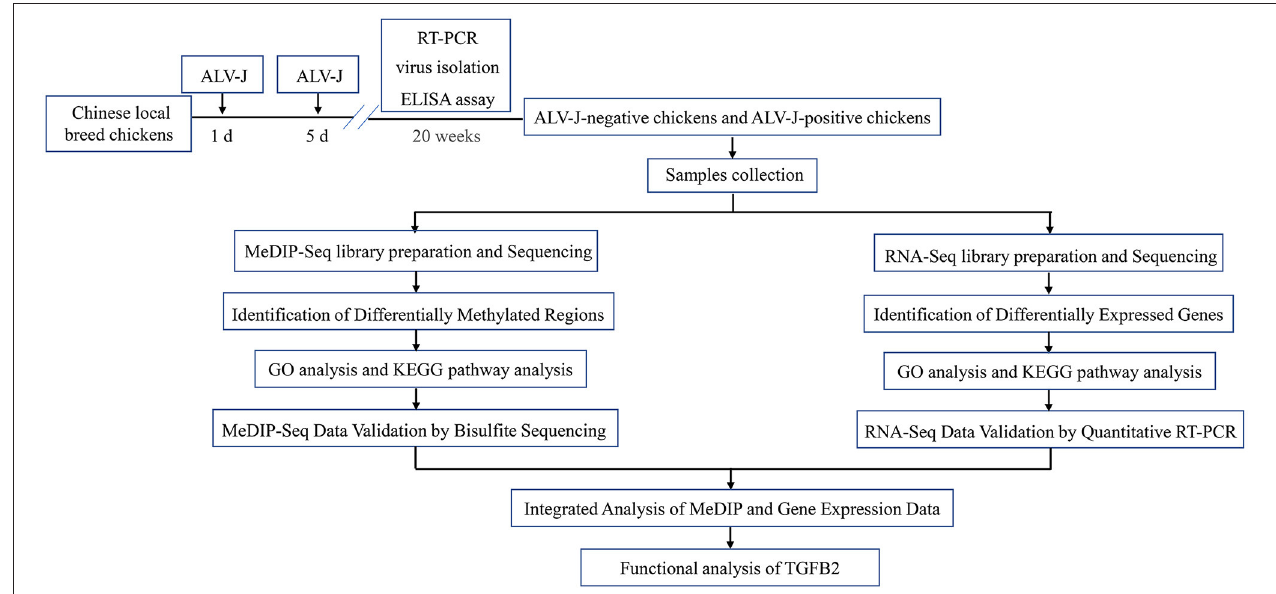
FIGURE 1 | Experimental design schematization.